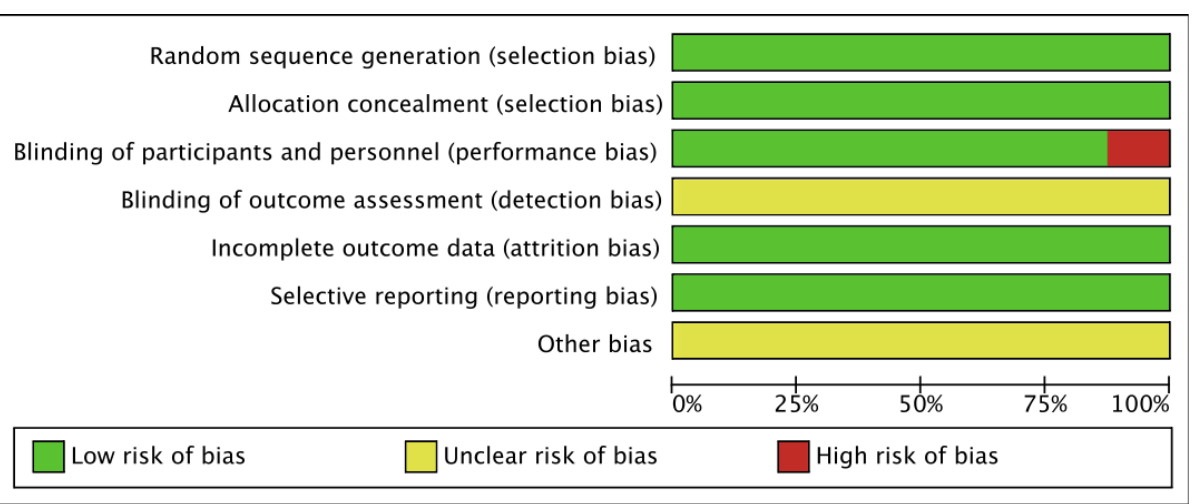
Figure 6. Funnel plot of each comparative analysis. Blue circles represent included studies, solid lines represent pooled effect sizes, dashed lines represent confidence intervals (95%).